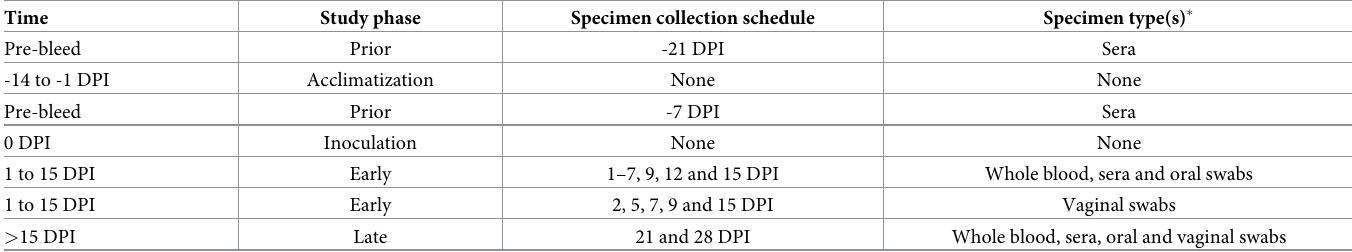
Table 1. Timeline of specimens collected according to study